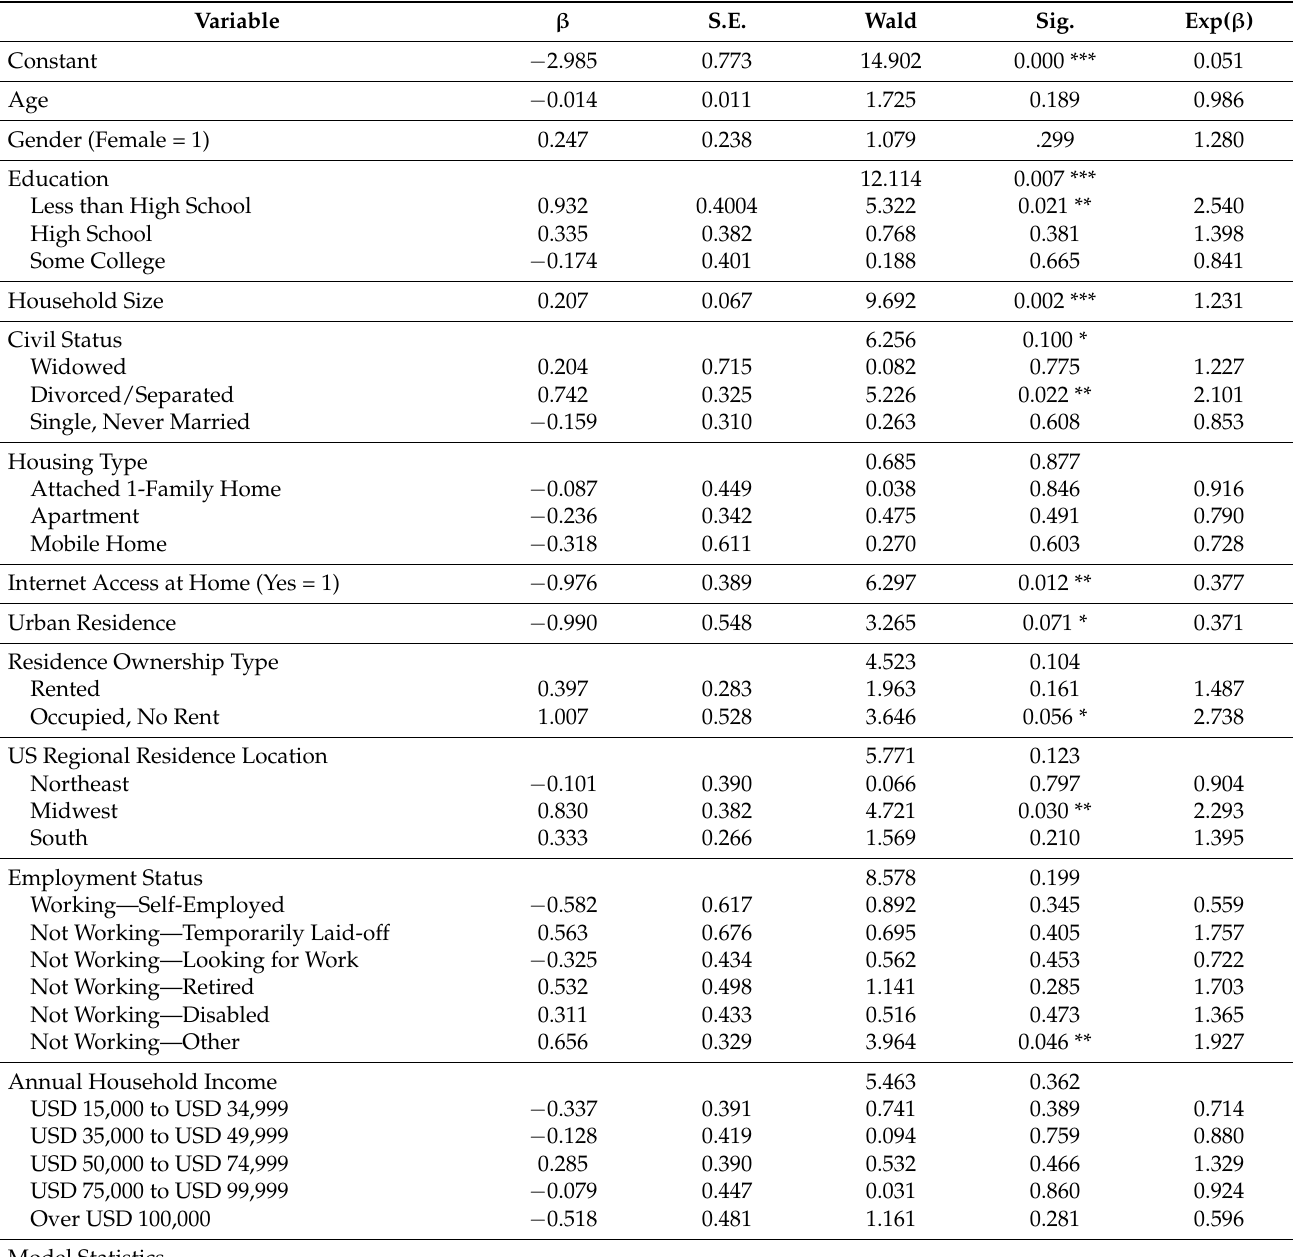
Table A3. Logistic Regression of Hispanic EIWA Selling Goods Offline (Selling Goods Offline = 1). Variable